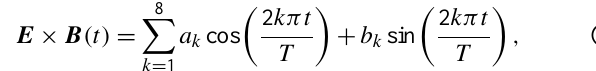
Fig. 3. The test region over the Pacific Sector. The red lines represent the three discrete SAMI2 runs. CINDI data throughout the orange box is averaged together to provide the average densities for the SAMI2 constraints.